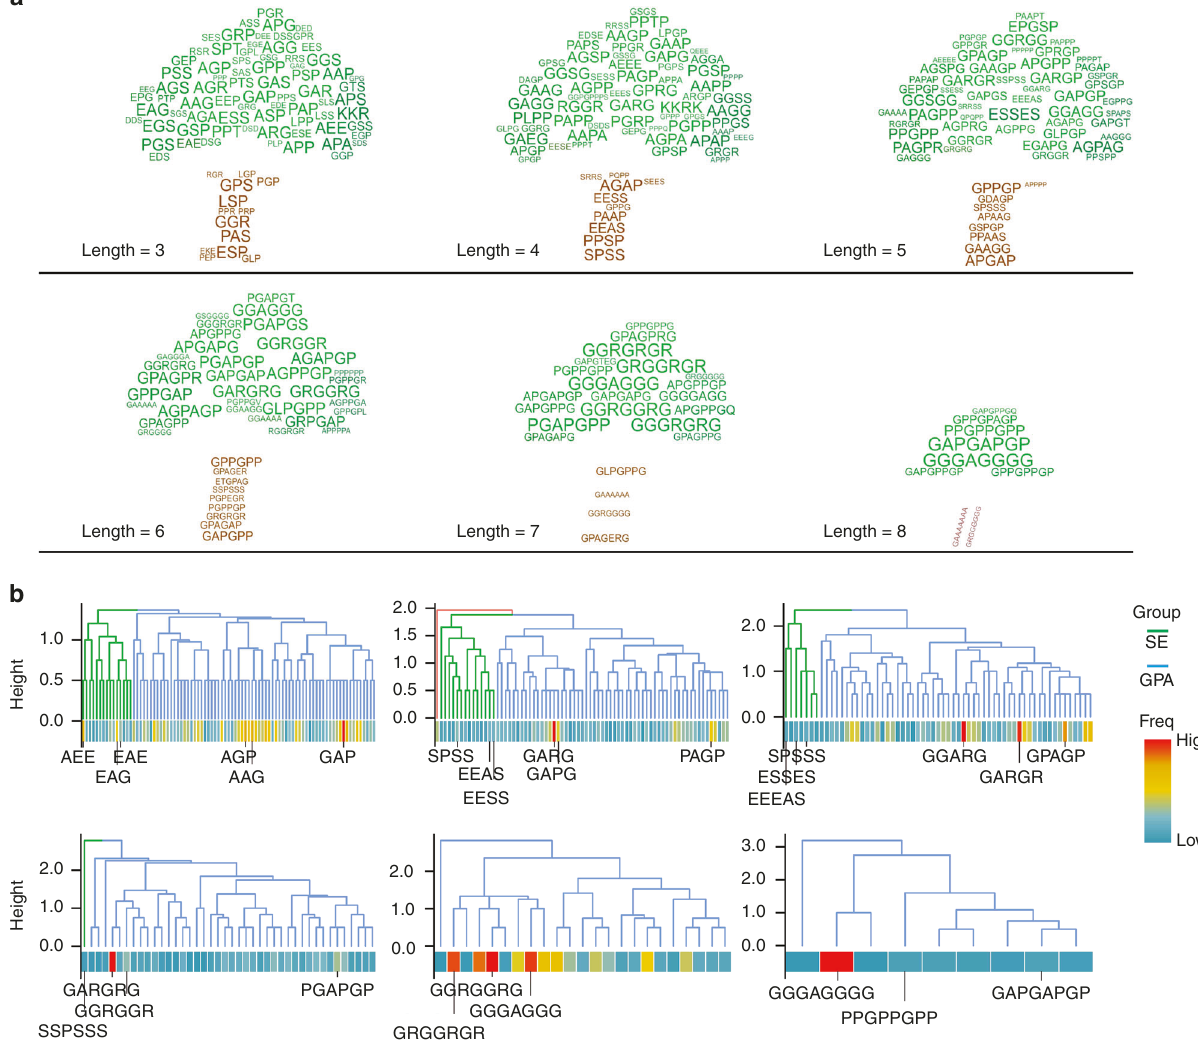
Fig. 2 Functional oligopeptide candidates for promoting osteogenesis. a Illustration of the output results for osteogenic-related oligopeptides, shown as clustering trees. Oligopeptides (3 – 8 AA in length) were fi ltered according to their frequency in the IDRs and ranked by probability value inferred from the N-gram. The oligopeptide candidates, composed of the amino acids with a probability greater than random events (>1/20 for 20 types of human amino acids), were ranked by the product of conditional probabilities of each AA. The font size represents the rank of oligopeptides. b Oligopeptides of 3 – 8 amino acids in length clustered into two major groups: the SE subgroup and the GPA subgroup (the residents were mainly composed of S/E or G/P/A). The top-ranked oligopeptides in each subgroup at each length (a total of 28 oligopeptides) were selected for further experimental investigation of osteogenic